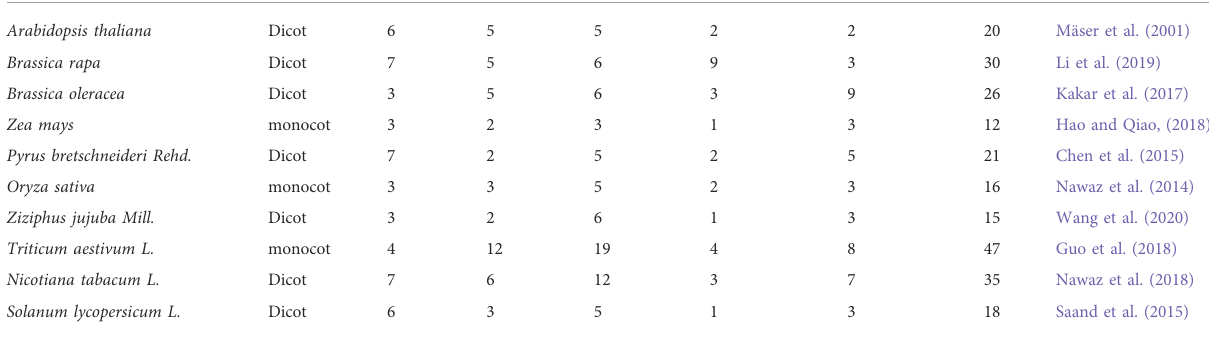
TABLE 1 Summary of CNGCs reported in other